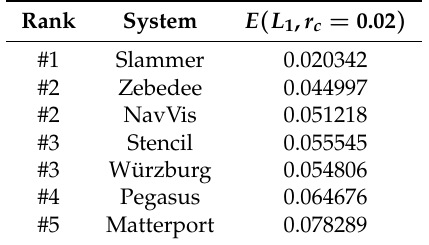
Table 2. Suggestive method ranking based on precision at length scales equaling to and under r c = 0.02 m, using the proposed metric results of Figure 11. Furthermore, numerical results for E using one value of r c are shown.